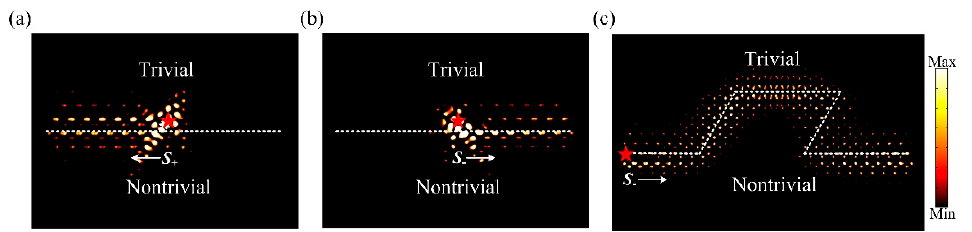
Figure 5. ( a , b ) Simulated electric field maps for one-way edge state excited with a positively and negatively circularly polarized dipole show unidirectional propagation towards left and right directions, respectively. ( c ) Electric field maps of robust one-way edge states along interfaces with sharp tuning angles show that the EM waves can transmit around defects without backscattering. Perfectly matched layers are imposed to the surrounds of the whole PC structures to absorb output waves.